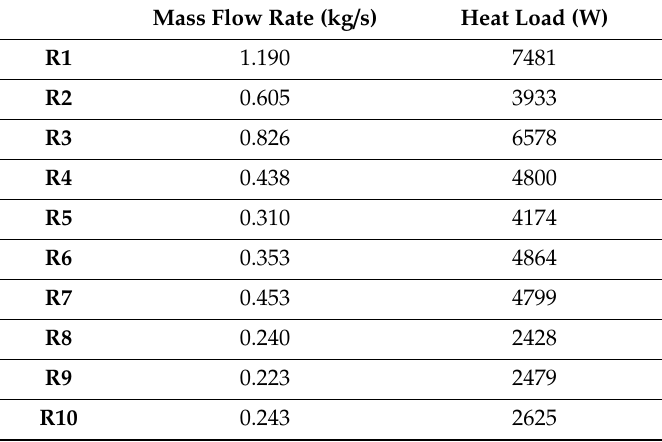
Table 4. Boundary conditions for the server racks—hard floor